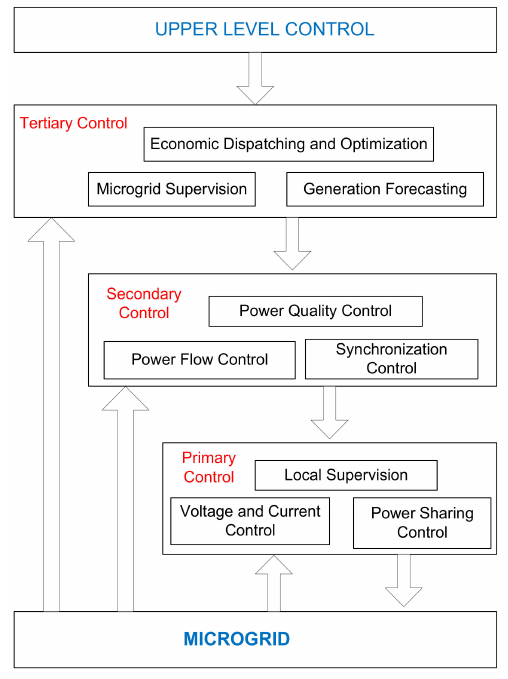
Figure 7. Hierarchal control of a